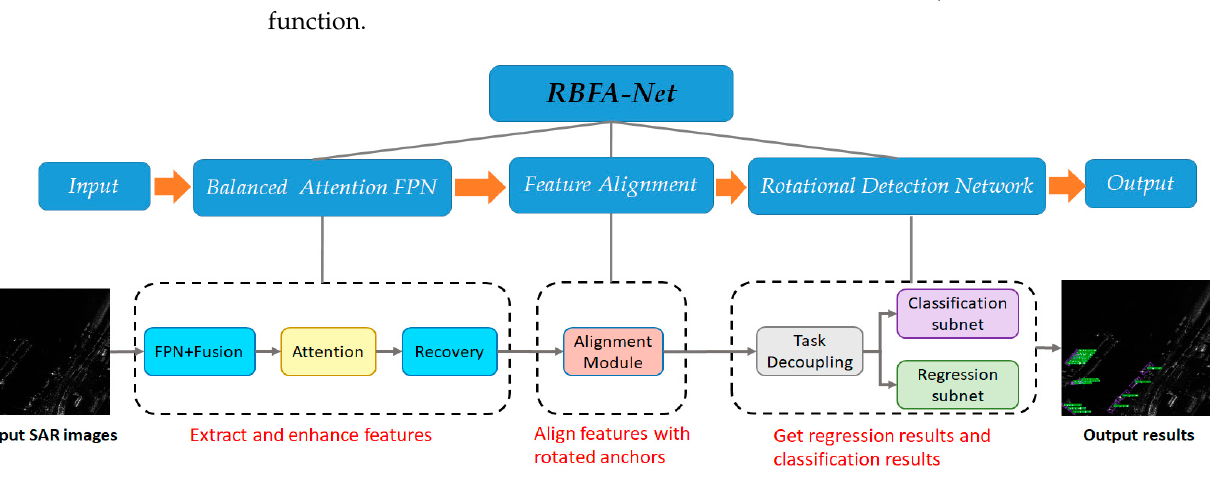
Figure 3. Architecture of RBFA-Net.